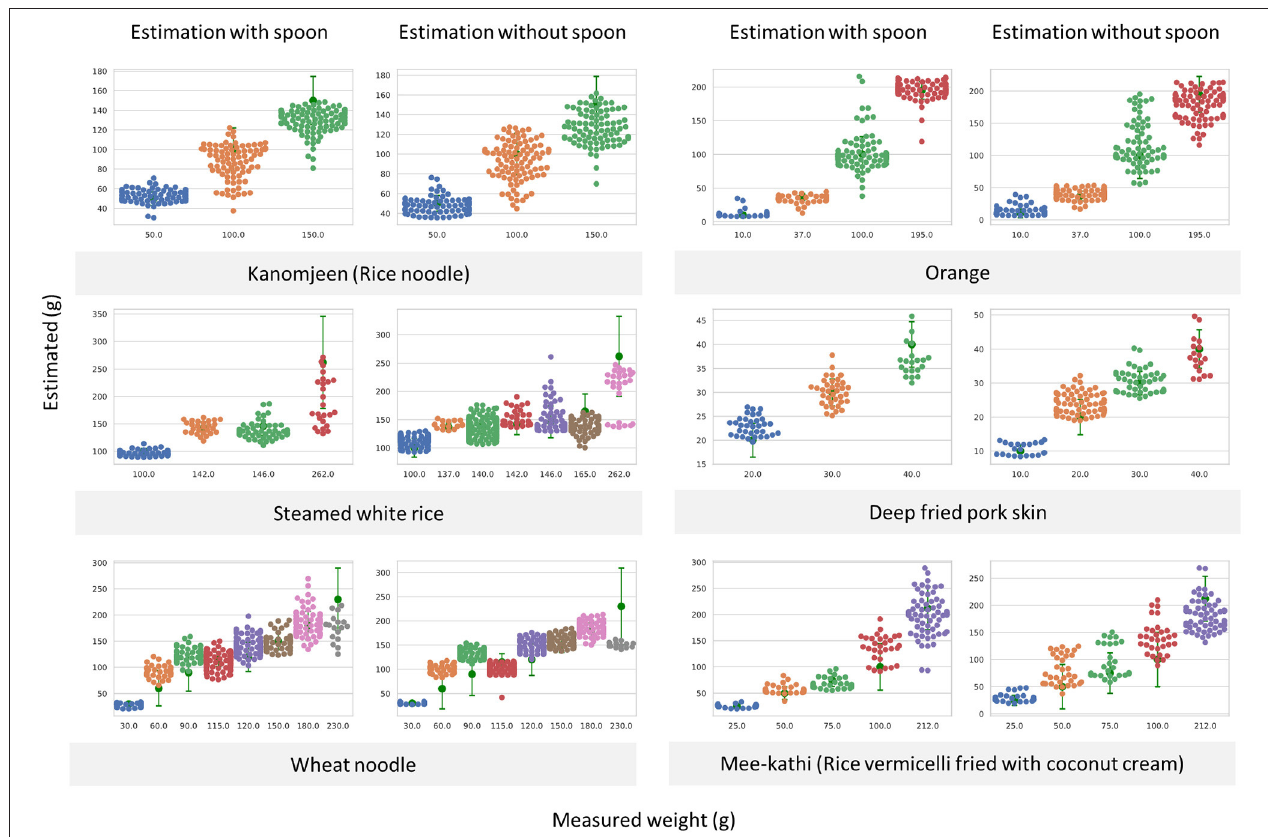
FIGURE 2 | Swarm plots illustrating measured weights and weight estimation results with and without using spoons as reference objects from the test dataset. This level of error could produce the RMSE of calculated carbohydrate < 10g for all